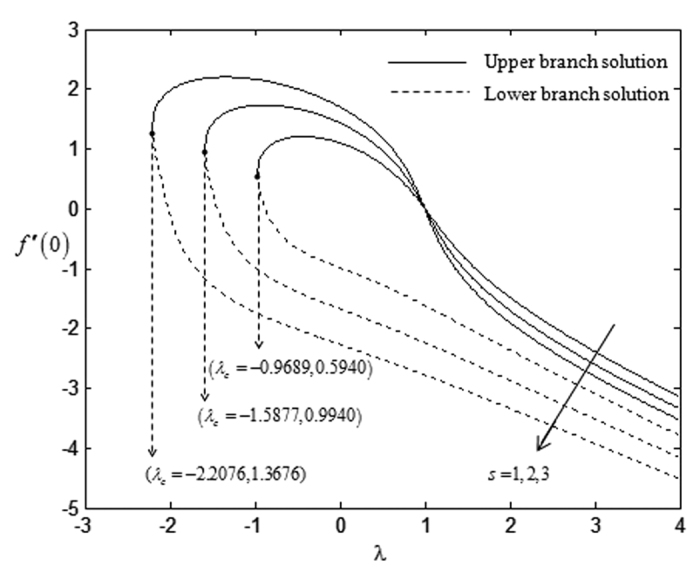
Variations of f ″(0) with λ for some values of s when β = −1 and K = 1.